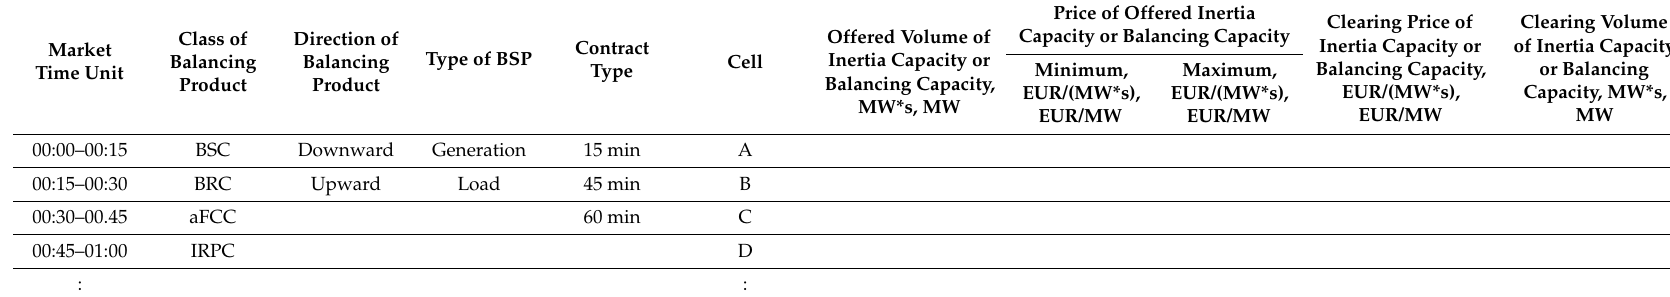
Table 1. Publication of aggregated data related to the trade in inertia capacity and balancing capacity.